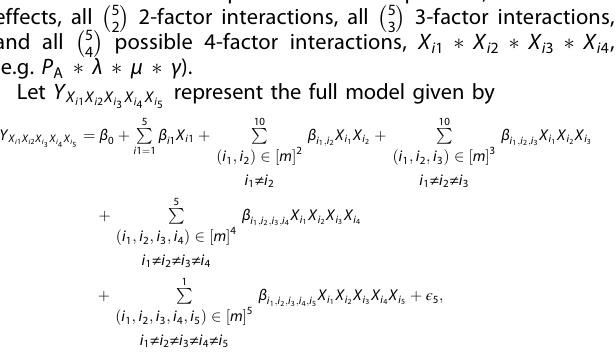
A low C p and high adjusted R 2 indicates a good model fi